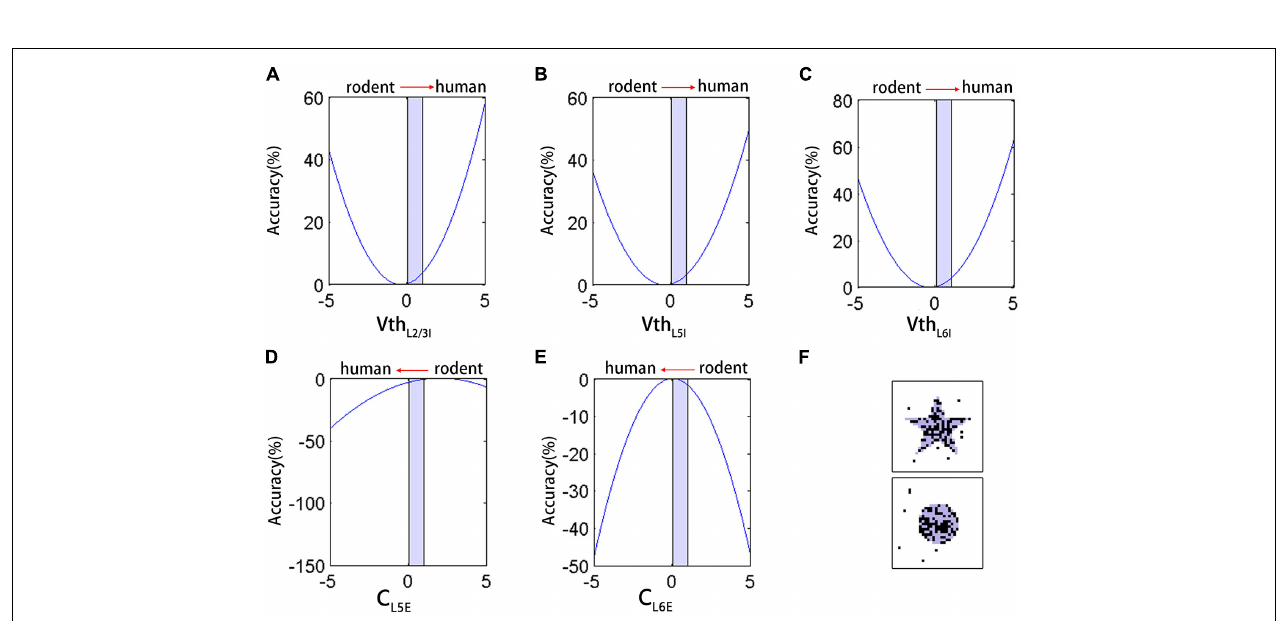
FIGURE 5 | The neuron parameters multiple non-linear regression fitting results. (A–E) The effect of Vth L 2 / 3 LL - IN , V thL 5 LL - IN , Vth L 6 LL - IN , C L 5 PC , and C L 6 PC on the accuracy during [0,1] (light blue shading). Red arrows indicate the direction of the parameters transition from rodent to human. (F) The network input (light blue shading) and output (black) after further increase V th